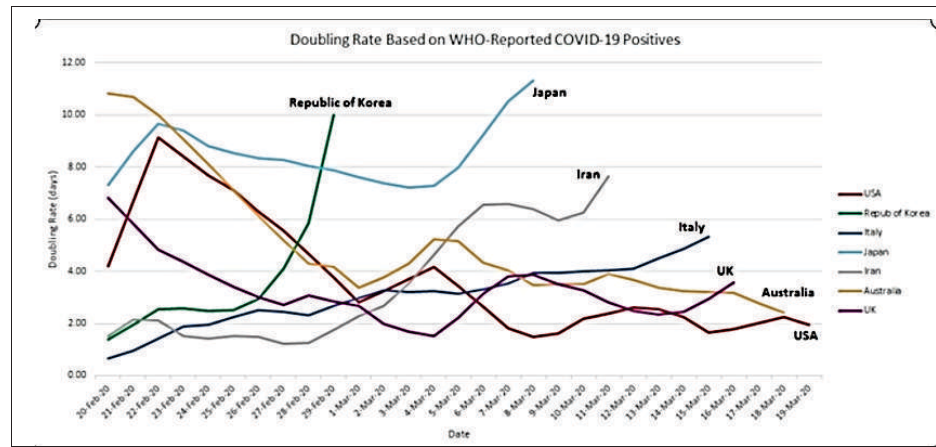
Figure 3: Doubling rates of selected countries